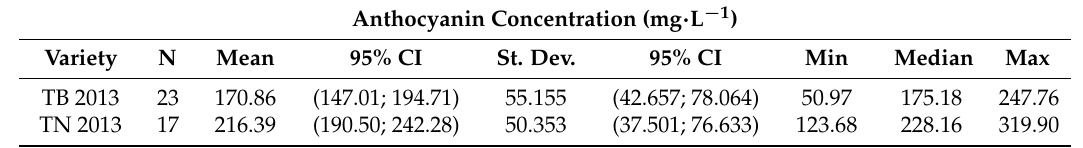
Table A10. Descriptive statistics of the samples used in the external test sets to further study the generalization capacity for the prediction of anthocyanin concentration.